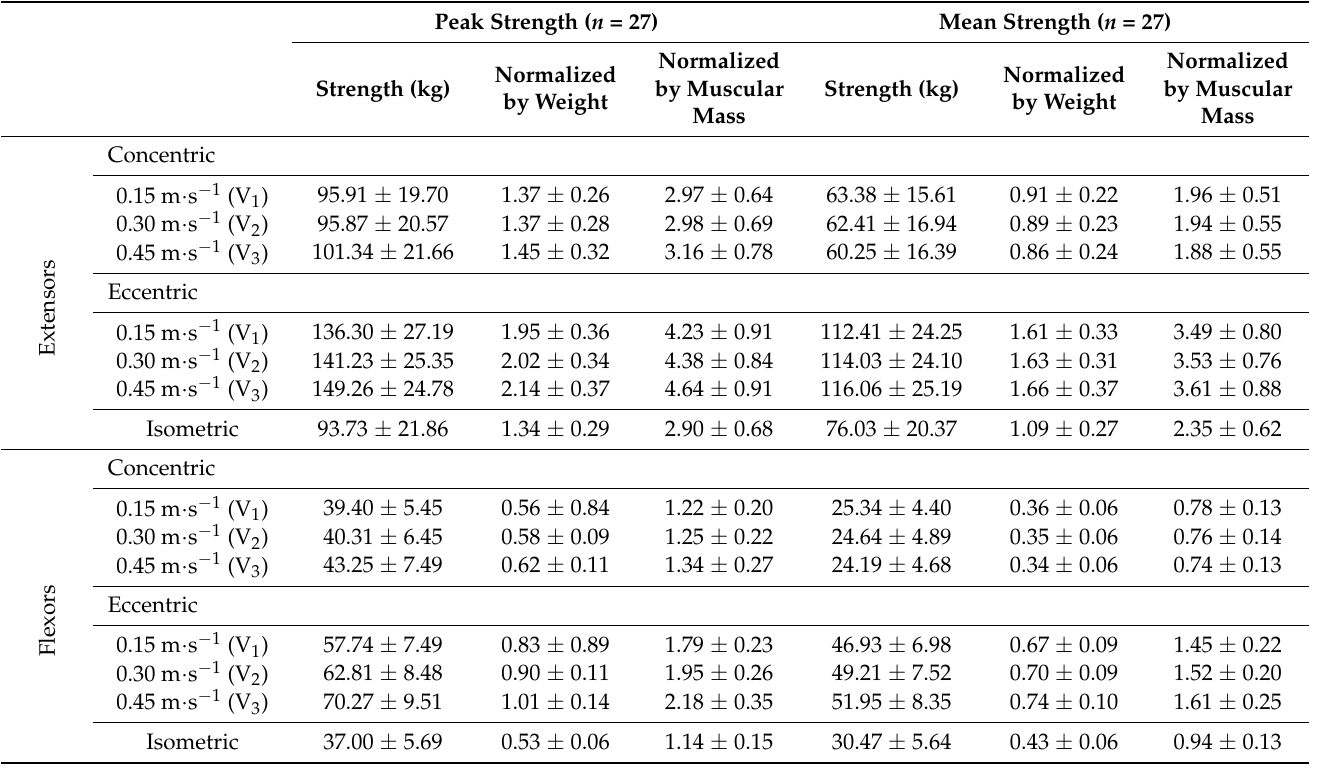
Table 2. Behavior of trunk strength ratios at different velocities.